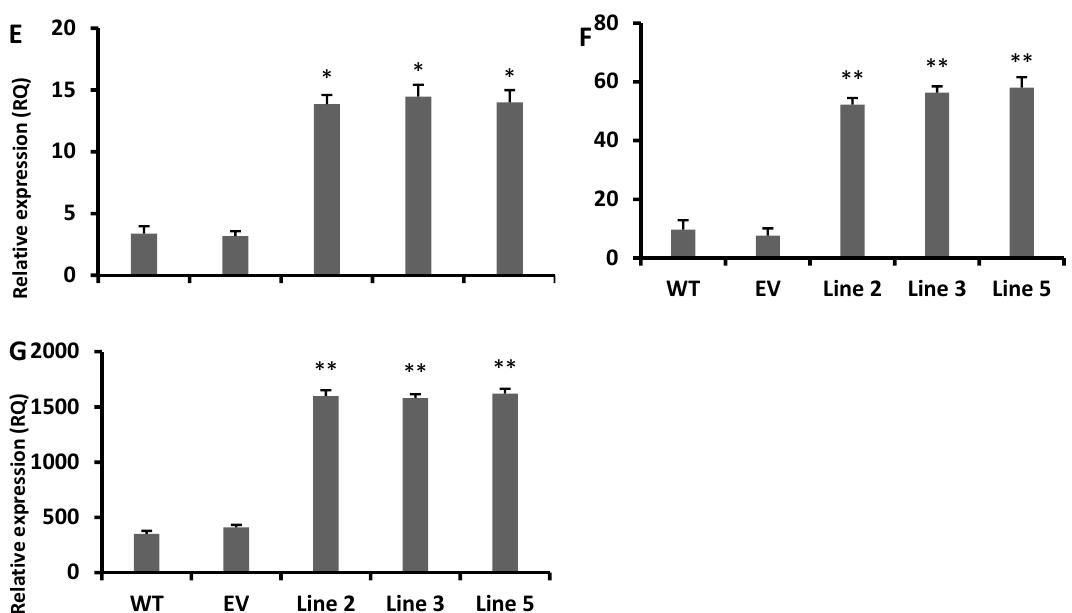
Figure 3. The gene expressions, total flavonoid contents and antioxidant activities of wild type and overexpressed lines without stress: ( A ) Total flavonoid contents, ( B ) antioxidant activity, ( C ) antioxidant capacity, ( D ) AT5G08640 flavonol synthase (FLS), ( E ) AT5G13930 TT4, ( F ) AT3G55120 TT5, and ( G ) AT3G51240 TT6. (WT) wild type and (EV) empty vector. A Student’s t -test was used to compare the CYT-OX and WT plants at * p < 0.05 and ** p < 0.01. Each value is a mean of three replicates.